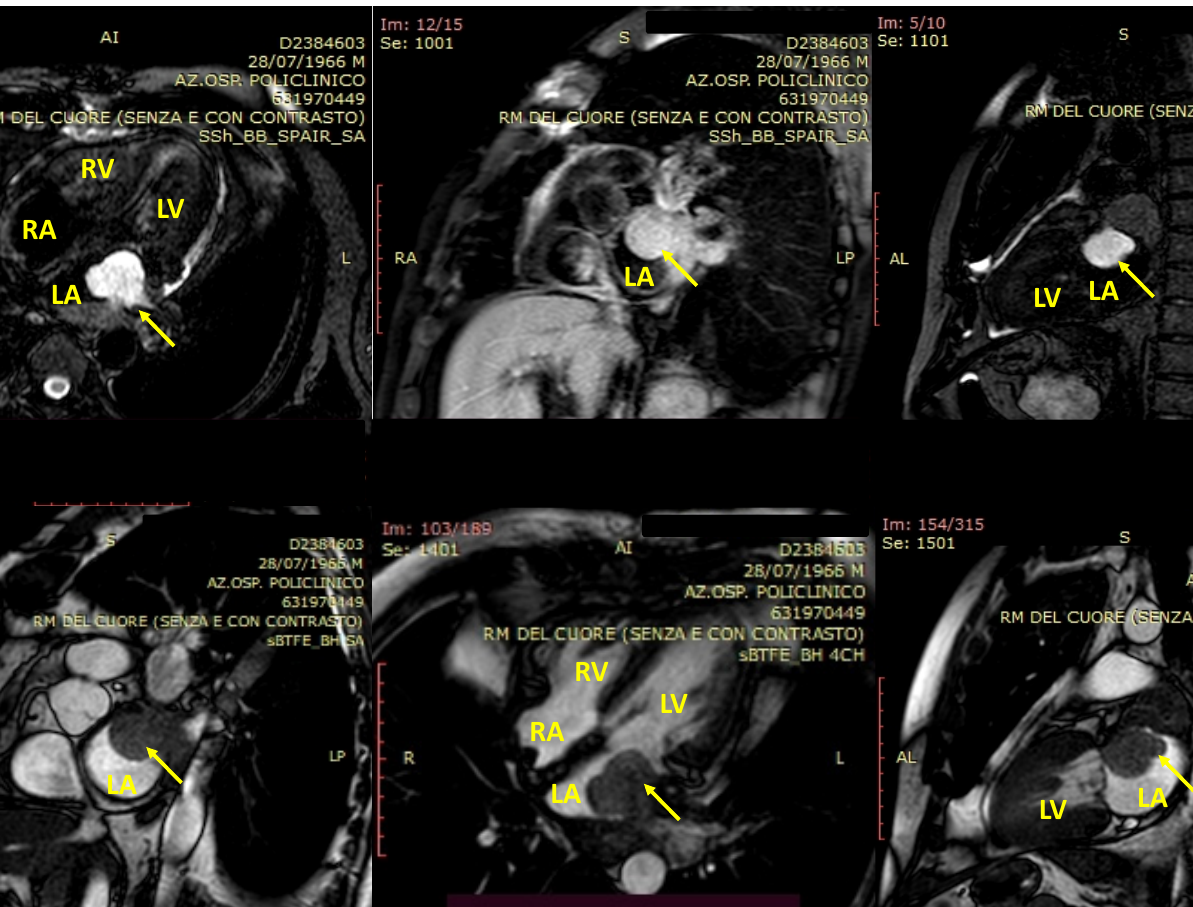
Figure 2. Cardiac magnetic resonance imaging of a cardiac sarcoma of the left atrium (arrow). The images revealed the presence of a cardiac sarcoma of the left atrium, which encroached upon the cardiac chamber with its sessile branch (dimensions: 4 × 4 cm). The origin of the mass rose up from the posterior wall of the atrium and extended into the left pulmonary veins, with no detectable cleavage planes to aortic and esophageal walls. The lesion demonstrated late and not homogeneous enhancement. LA: left atrium; LV: left ventricle; RA: right atrium; RV: right